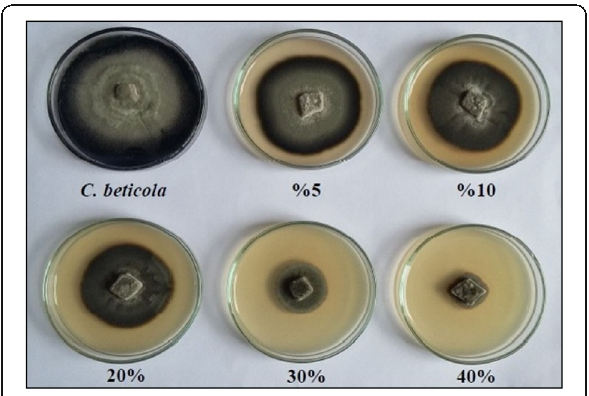
Fig. 3 Effect of culture filtrate of Penicillium frequentans isolate No. 4 on mycelial growth of Cercospora beticola in